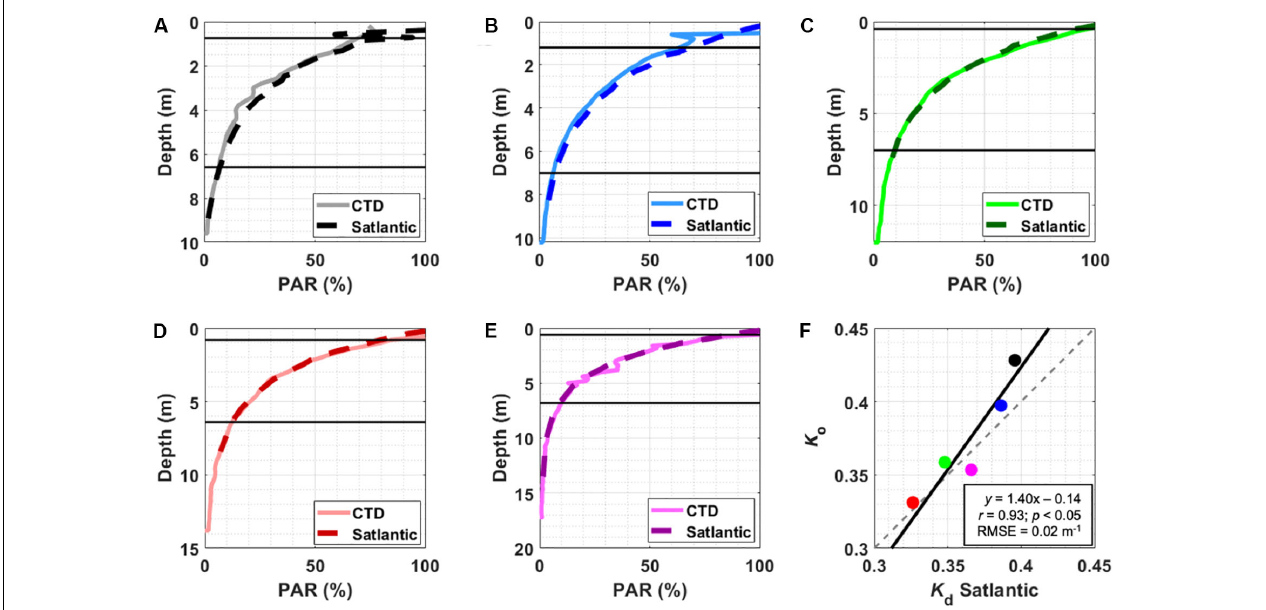
FIGURE 4 | (A–E) Profiles of PAR (%) acquired with the PAR-meter (CTD) and a free-falling optical profiler (Satlantic) for the 5 stations visited during the calibration exercise on Jun. 13th, 2019. Black horizontal lines indicate the depth limits considered for estimating K d (PAR) for each station. (F) Scatter plot of K d (PAR)-Sat vs. K o (PAR)-CTD (m - 1 ); solid black line shows the orthogonal linear regression fit and the dashed gray line indicates the 1:1 line.